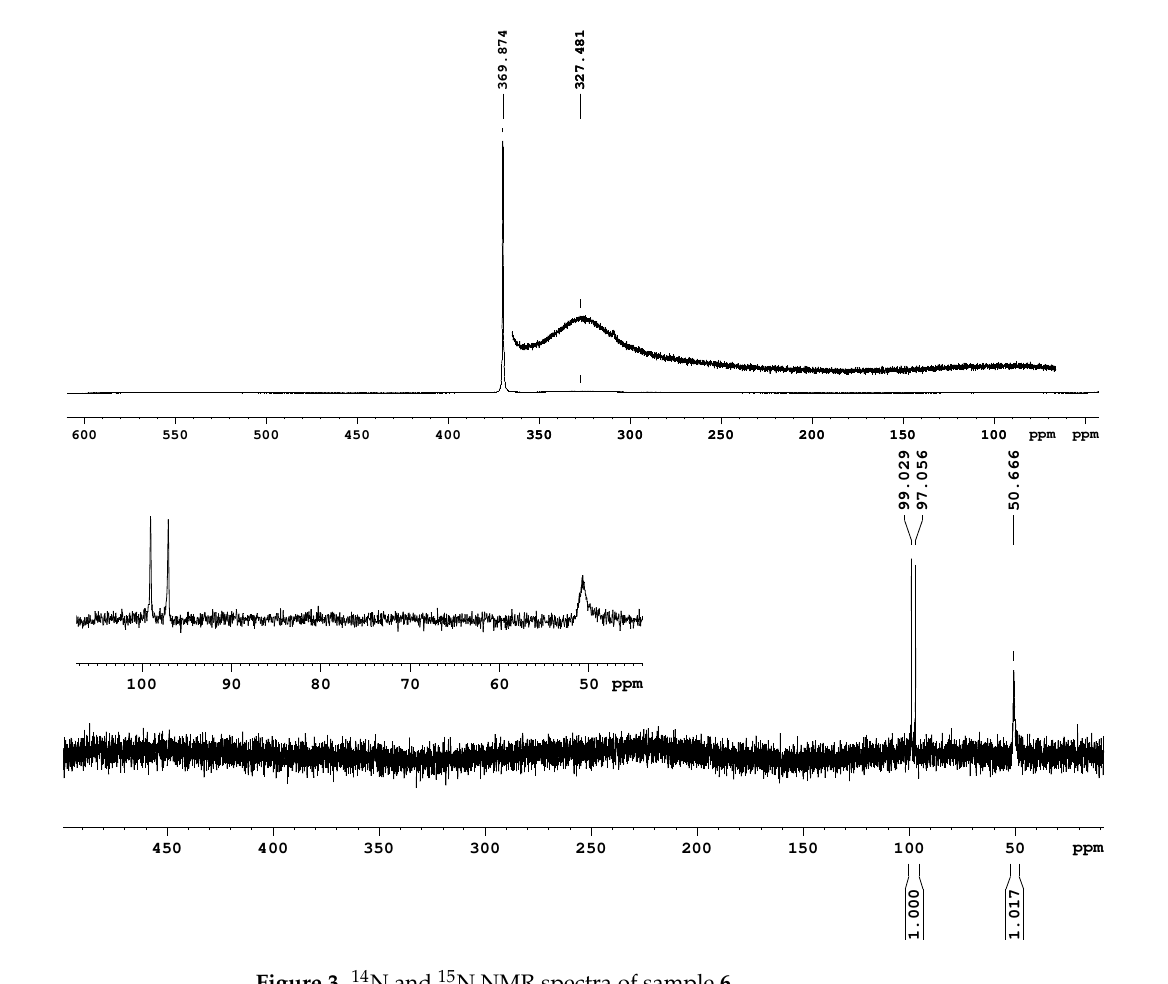
Figure 3. 14 N and 15 N NMR spectra of sample 6.